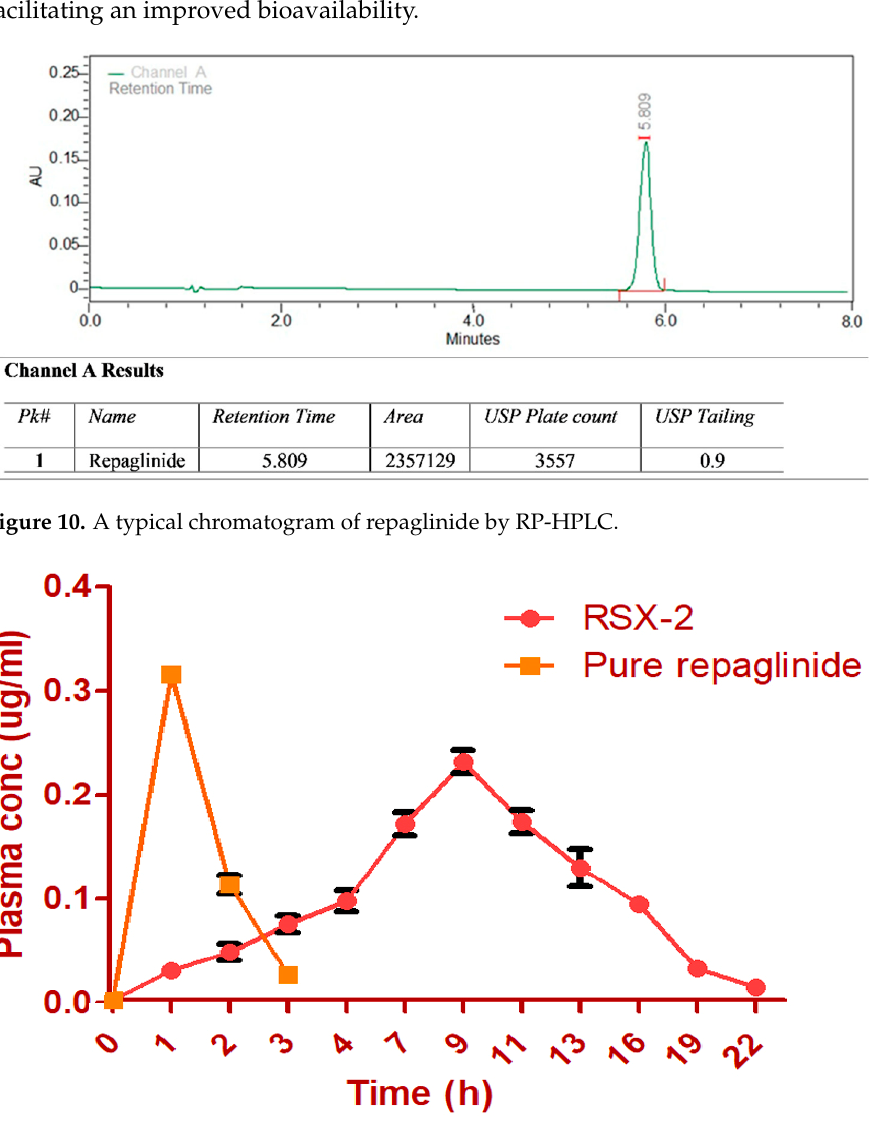
Figure 11. Plasma concentration–time profile for RSX ‐ 2 and pure repaglinide (n = 6).